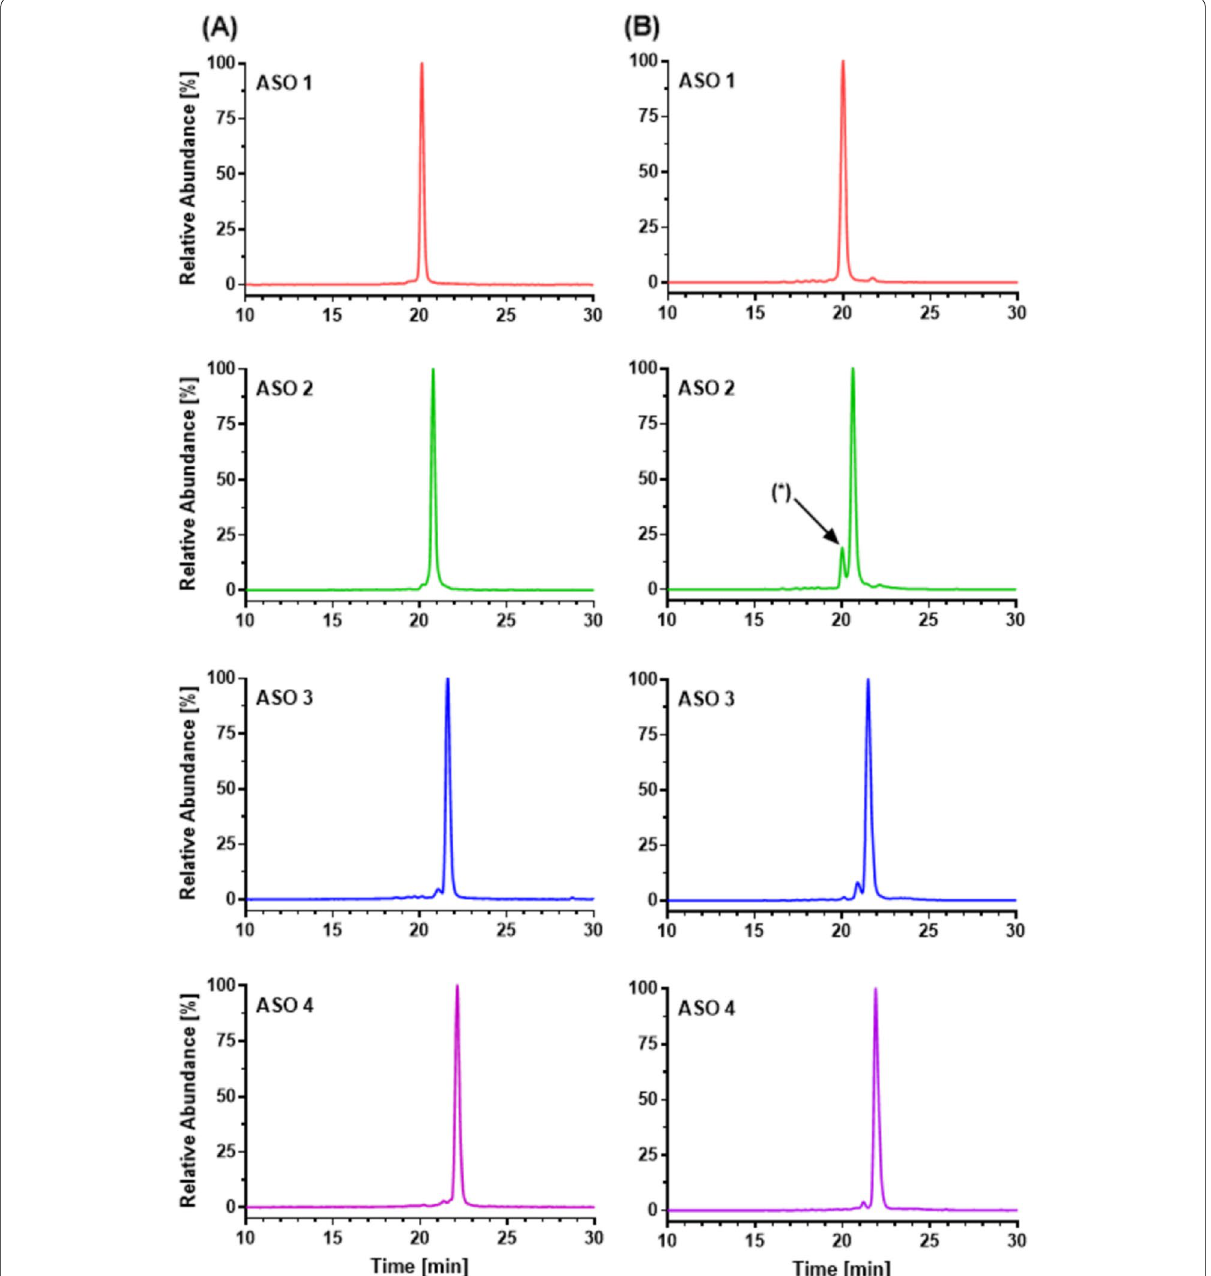
Fig. 4 HPLC measurements (AIF, normalized) of naked ASO constructs from the MetID study. From the top: ASO 1 (untagged), ASO 2 (NSP), ASO 3 (NMM), and ASO 4 (NEM). A Reference compounds. B After 72 h incubation in primary mouse hepatocytes. (*) Arrow indicates the undesired degradation product of hydrolysis, which results to the loss of the